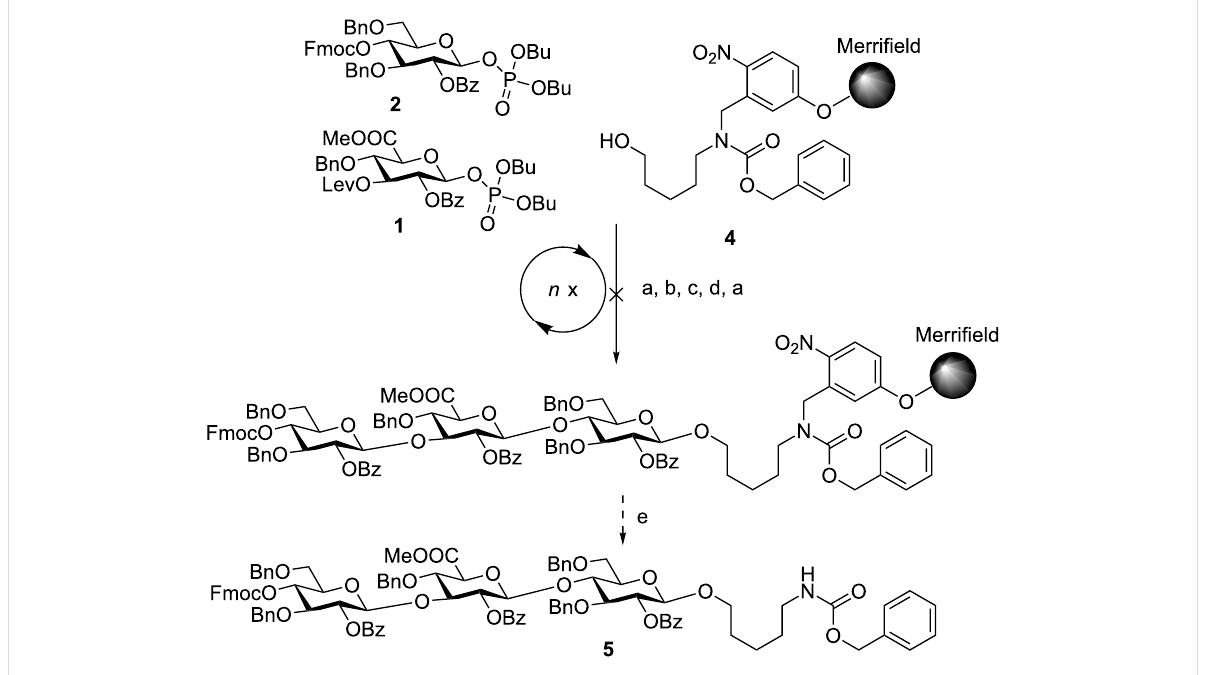
Scheme 1: Attempted assembly of SP3 trisaccharide 5 using glycosyl phosphate building blocks 1 and 2 . Reagents and conditions: a) 2 (3 equiv), TMSOTf, CH